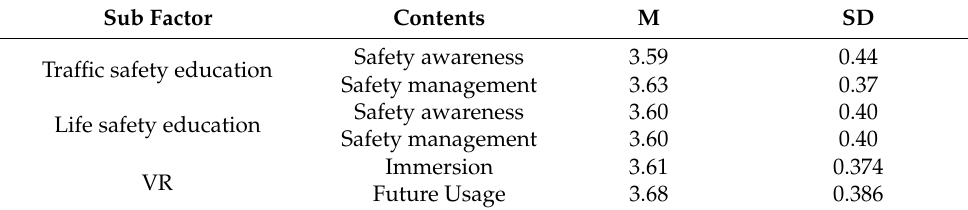
Table 4. Preventive attitude effect of safety education using